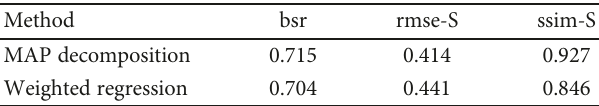
Table 1: The average performance of MAP decomposition and locally weighted regression on the validation set with 100 standard chest radiographs. bsr denotes the bone suppression ratio. rmse-S and ssim-S denote the root mean squared error (rmse) and the structural similarity image measure (ssim) for the reconstructed soft tissue,